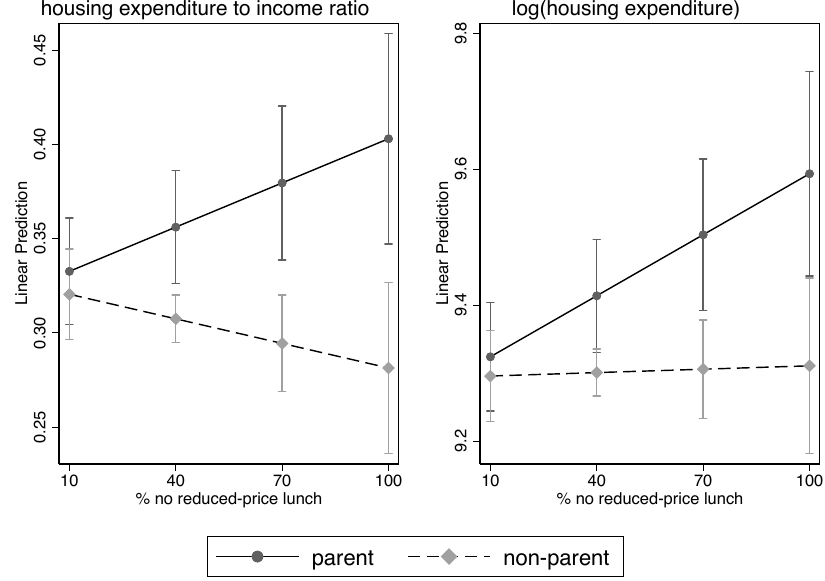
Figure 3: Predicted housing expenditures by parental status.